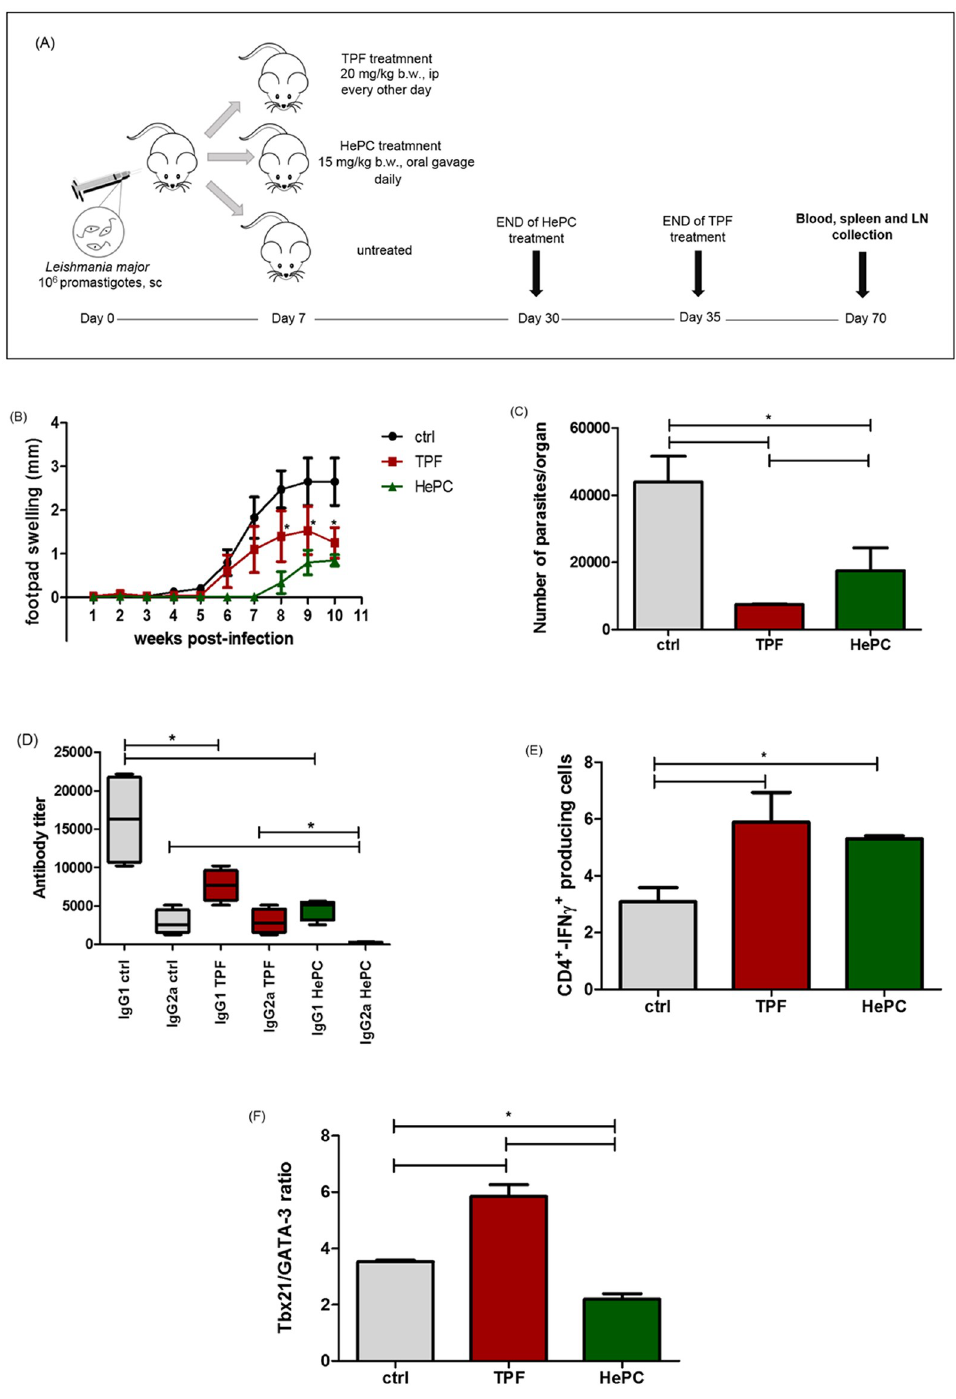
Fig 9. Therapeutic effect of TPF in a murine experimental model of cutaneous leishmaniasis. (A) Definition of treatment schedule and experimental groups . BALB/c mice were subcutaneously infected into the right hind footpad with 10 6 L . major promastigotes and one week later, were either treated with TPF (20 mg/kg b.w., ip) or HePC (15 mg/kg b.w., oral gavage) for up to 28 days or left untreated (control group). (B) Time course of L . major infection . The increase in footpad swelling was monitored weekly by measuring the increase of footpad thickness (in mm) as compared with the uninfected contralateral footpad. Results are expressed as mean values ± SD. (C) Parasite load estimation in popliteal lymph nodes of TPF-treated mice . Parasite load was determined at five weeks post-treatment termination by a limiting dilution assay. Values represent the mean value ± SD of five animals per experimental group. (D) The